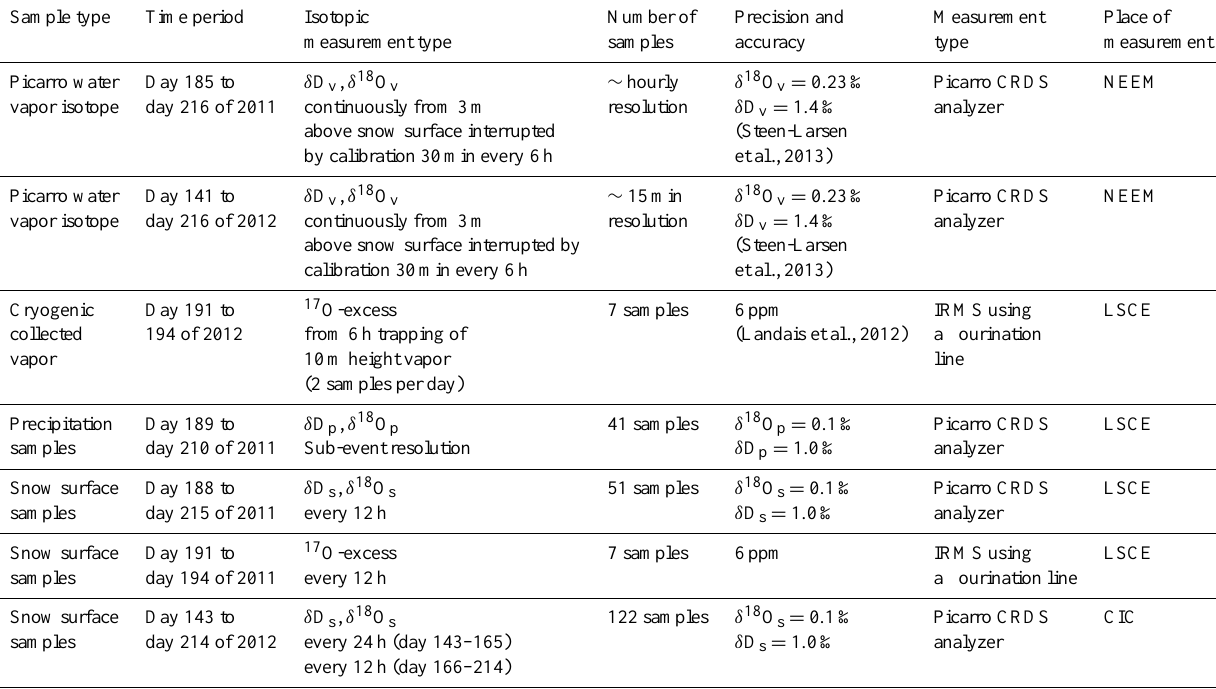
Table 1. Overview of data collected during the 2011 and 2012 field